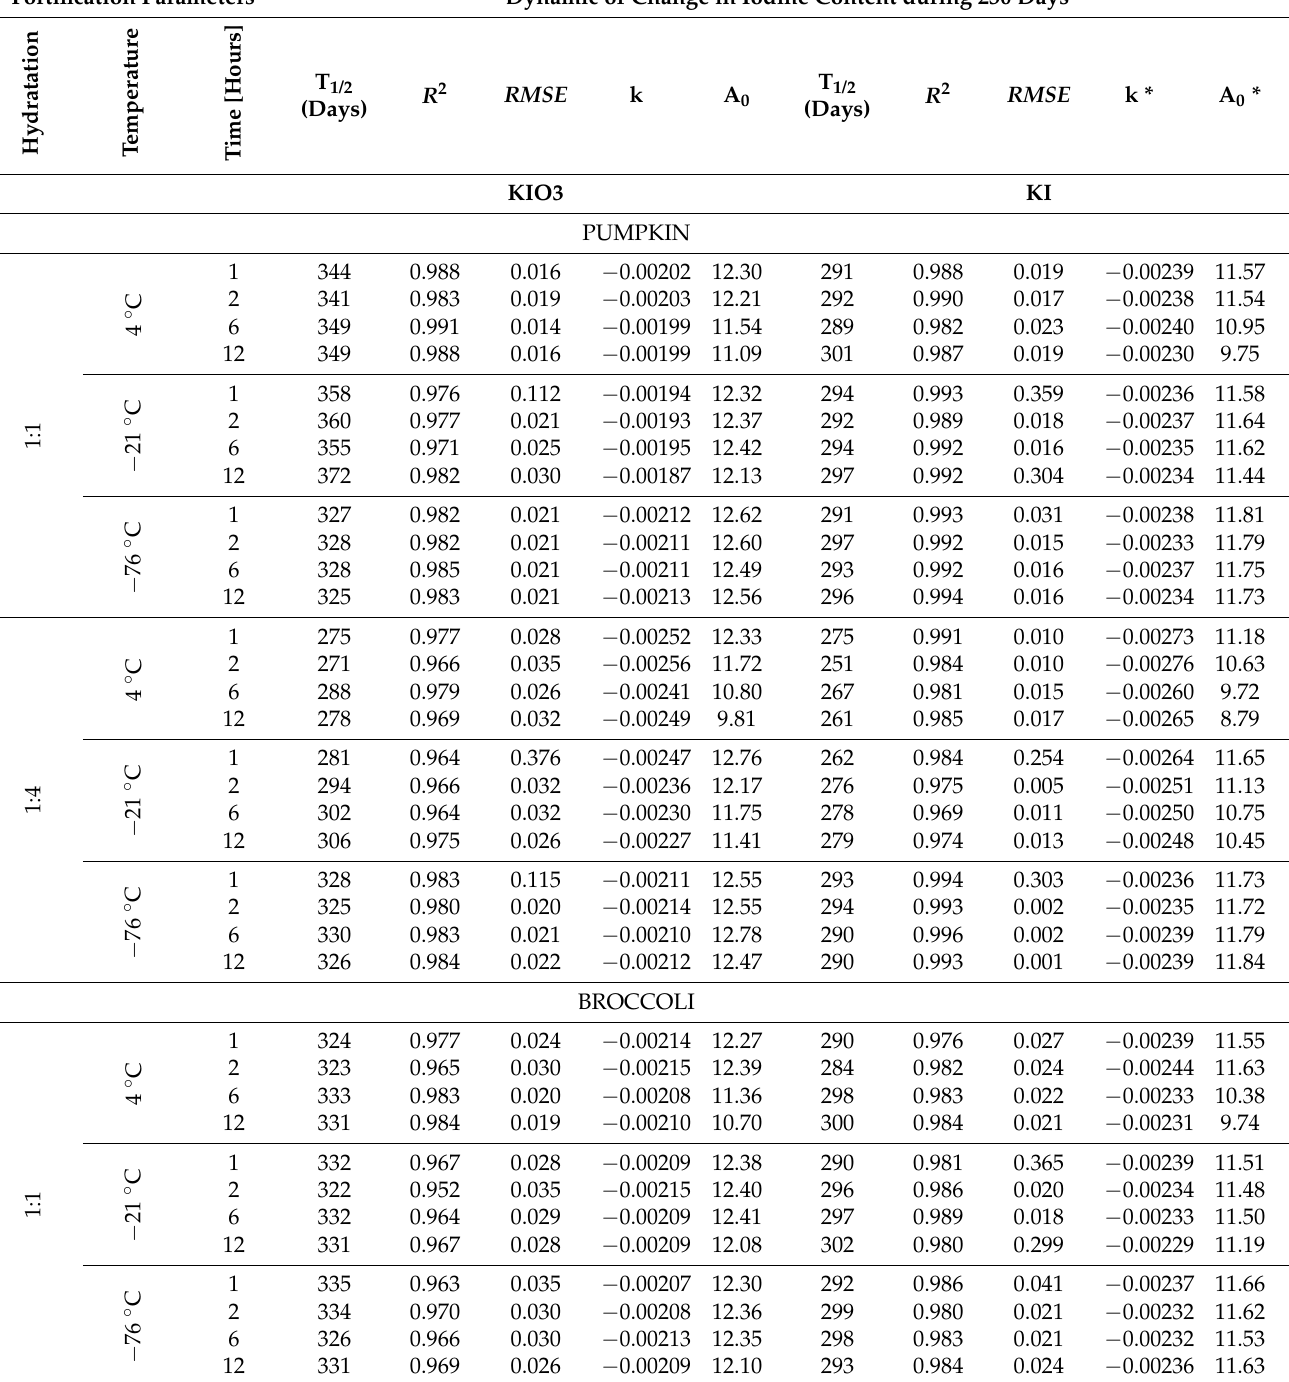
Table 2. Dynamic of changes in iodine content (mg kg − 1 ) during 230 days of storage of the dried iodine fortified vegetables under various conditions (temperature, hydration, and